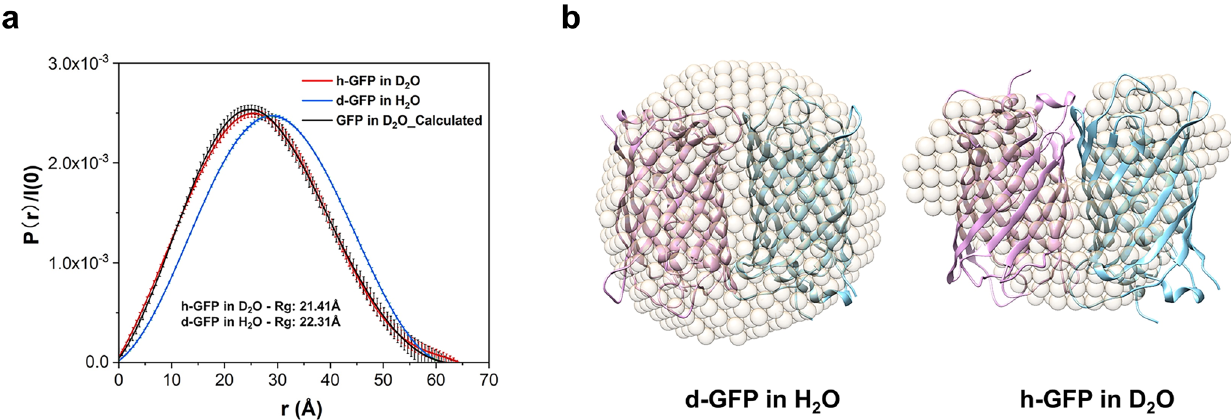
Fig. 3 | Reconstruction of free d-GFP and h-GFP. a Pair distance distribution function(PDForP(r))curvesforfreed-GFPinH